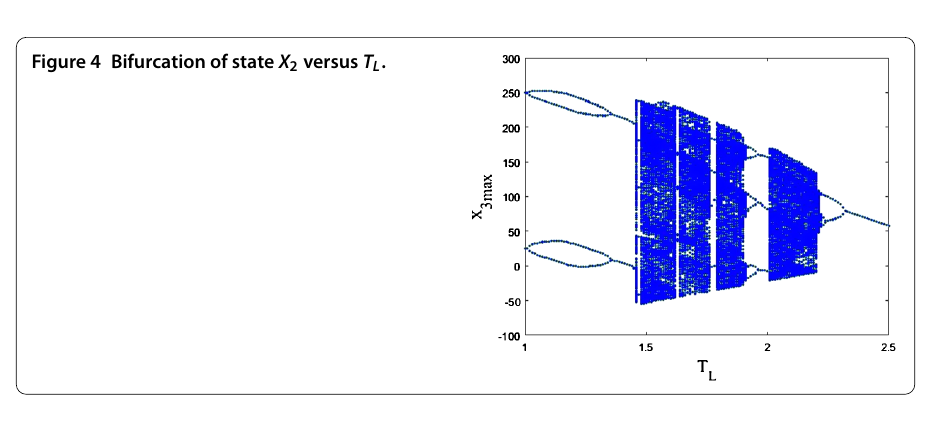
Figure 5 Bifurcation of state X 1 versus q